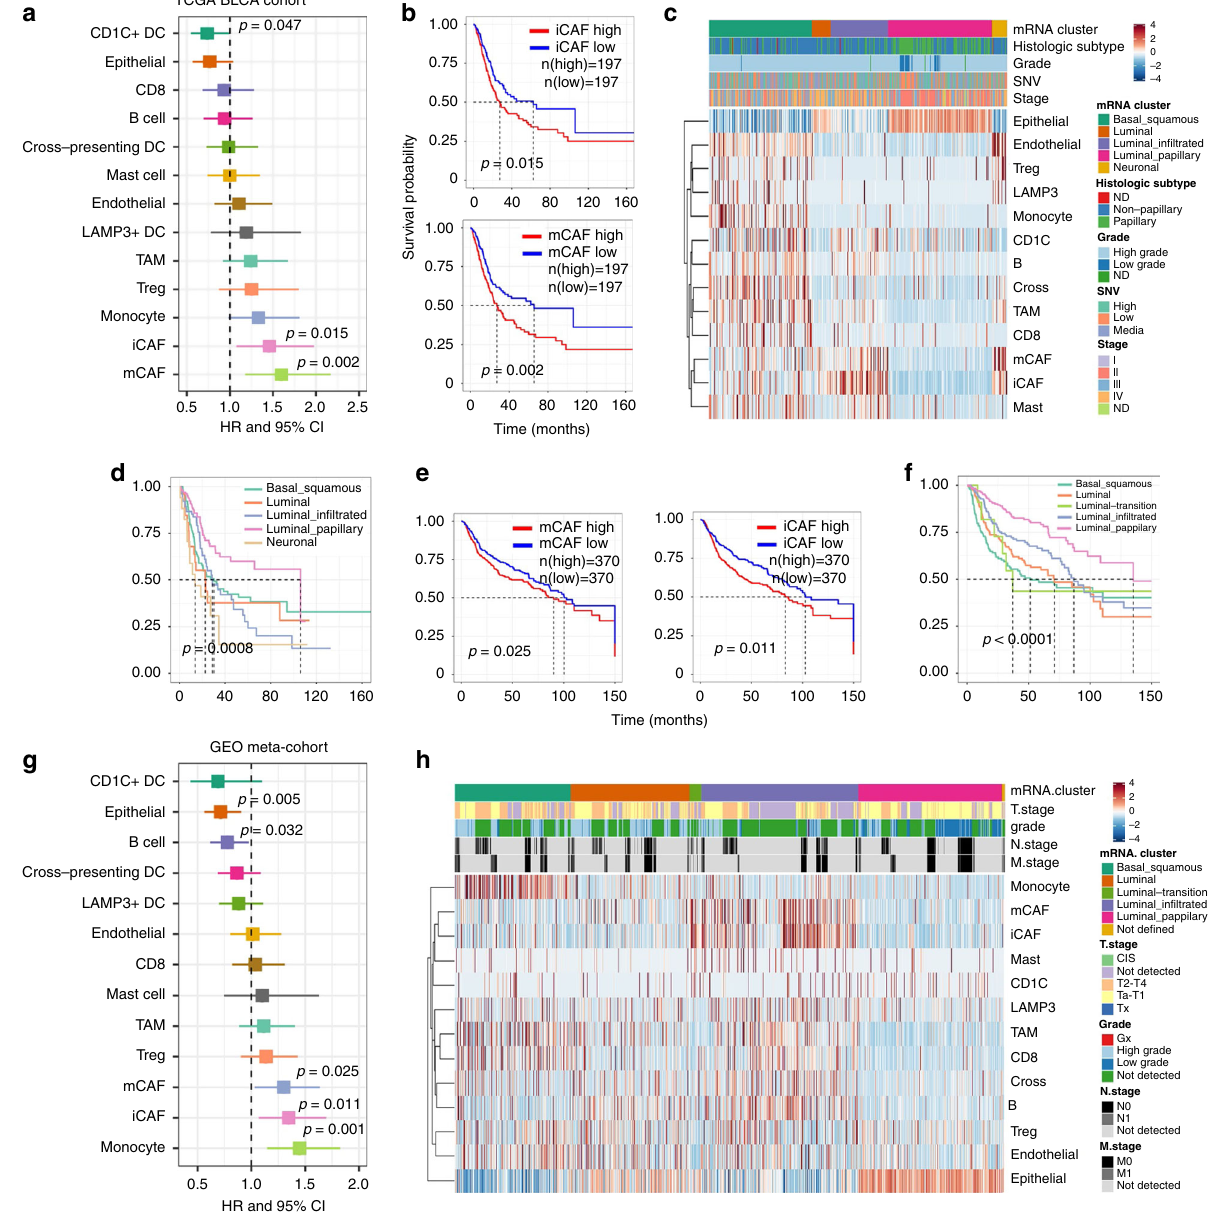
Fig. 5 Molecular subtypes of BC were caused by heterogeneity of TME. a Association between relative cell abundance and patient survival from TCGA BLCA cohort (COX regression analysis). b Kaplan – Meier curves for TCGA BLCA patients. P value was calculated with log-rank test. c Heatmap of cell abundance predicted per sample from TCGA BLCA cohort by CIBERSORTx. Shown are row z -score. d Kaplan – Meier survival curve for TCGA BLCA patients, grouped by molecular subtypes. e Kaplan – Meier survival curves for microarray-based meta-cohort patients. f Kaplan – Meier survival curve for microarray-based meta-cohort patients, grouped by molecular subtypes. P values of ( d – f ) were calculated with log-rank test. g Association between relative cell abundance and patient survival from microarray-based meta-cohort (COX regression). h Heatmap of cell abundance predicted per sample from microarray-based meta-cohort by CIBERSORTx. Shown are row z